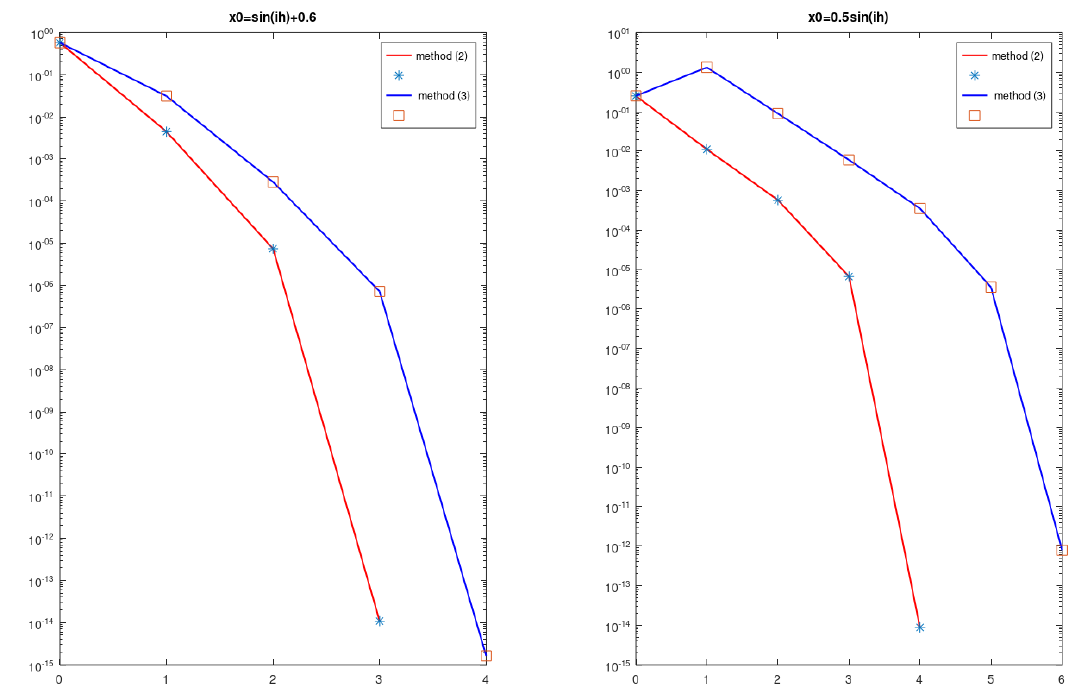
Figure 1. Example 2: norm of residual at each